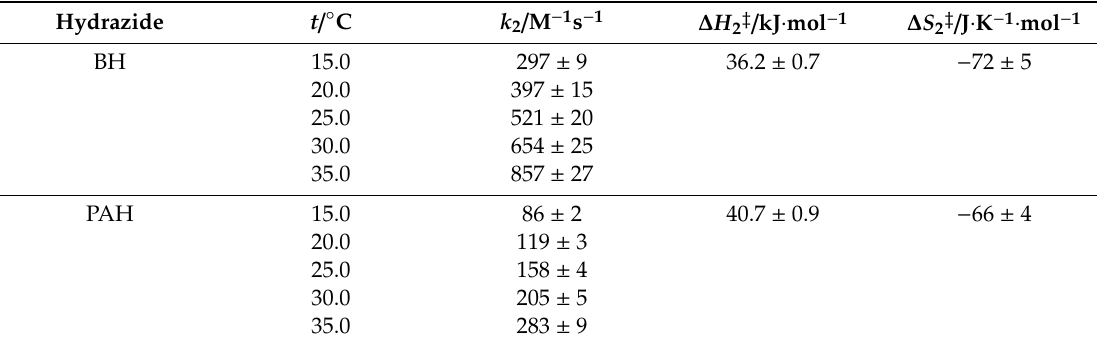
Table 3. Rate constant k 2 as a function of temperature and activation parameters for oxidation of the neutral forms of BH and PAH defined in Figure 7 by [IrCl 6 ] 2 − at µ = 1.0